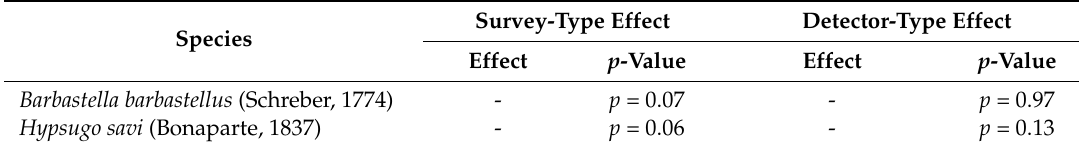
Table 2. Effect of survey type—car transect survey (CTS) vs. point-count survey (PCS)- and detector type (Tranquility Transect TT vs. D240x).